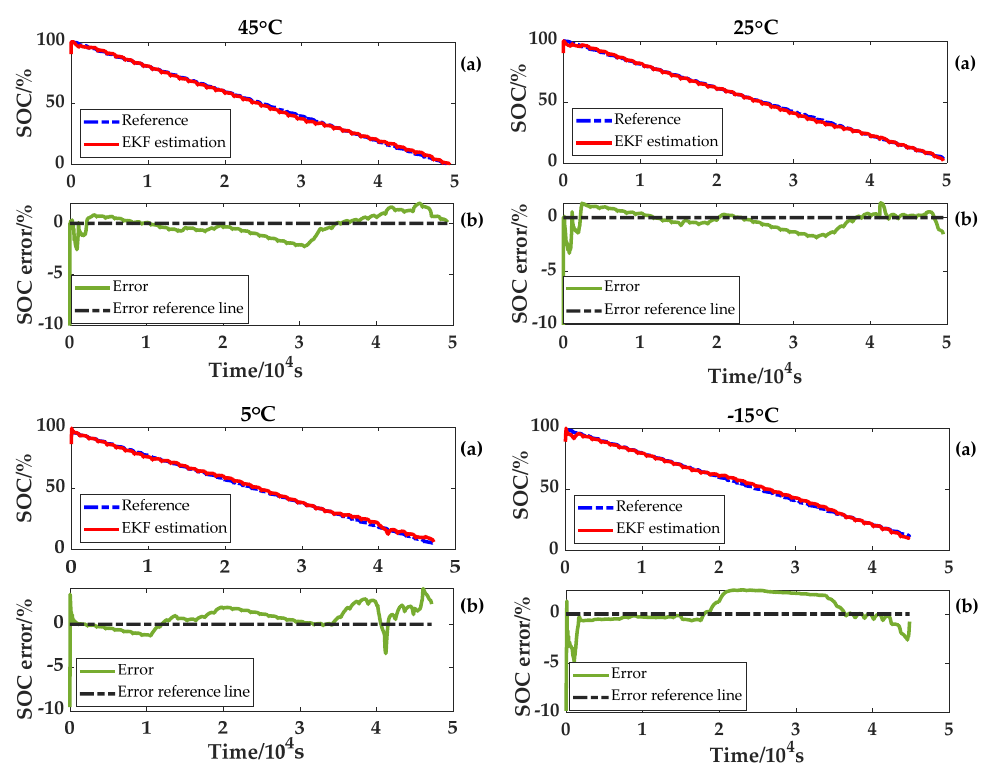
Figure 13. SOC estimation results and errors at different temperatures. ( a ) SOC estimation result at each temperature and ( b ) SOC estimation error at each temperature.